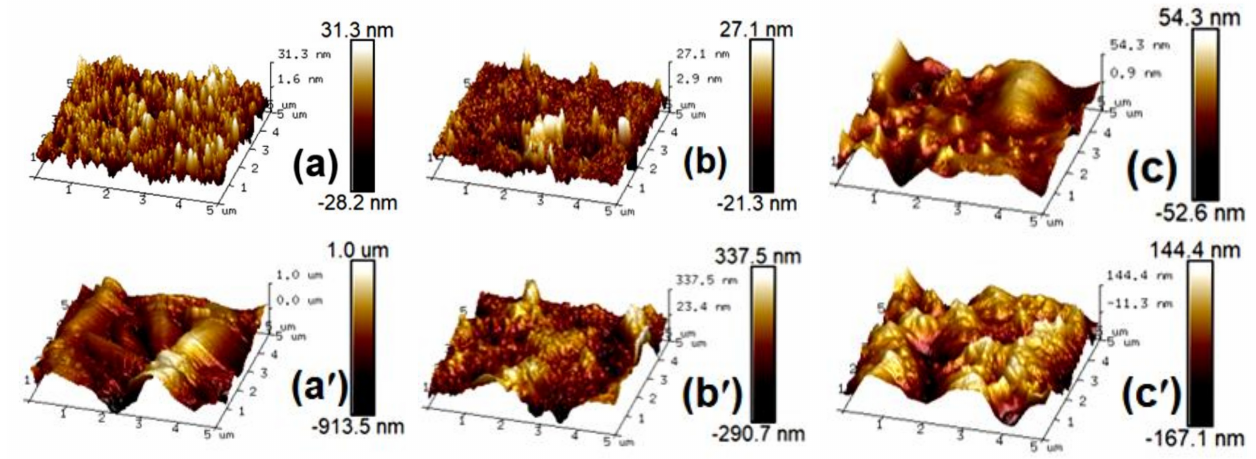
Figure 9. AFM three-dimensional structure of specimens surface: ( a , a (cid:48) ) for specimen #1 before/after corrosion; ( b , b (cid:48) ) for specimen #2 before/after corrosion; ( c , c (cid:48) ) for specimen #3 before/after